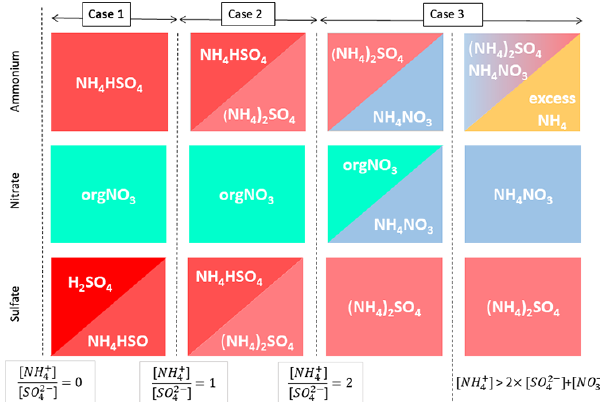
Figure 1. Schematic representation of the inorganic apportionment scheme. The scheme is divided into three cases according to the ratio of [NH + ] to [SO 2 − ]. [NH + ] first combines with [SO 4 ] to form 4 4 4 NH 4 HSO 4 (Case 1), then further to ( NH 4 ) 2 SO 4 (Case 2). In these cases, any nitrate observed is considered organic. In Case 3 leftover [NH + ] then associates with [NO − ] until all the inorganic anions are 4 3 neutralised. Any leftover [NH + ] is labelled as “excess NH + ”. A full 4 4 description of the scheme is given in the Supplement (Sect.